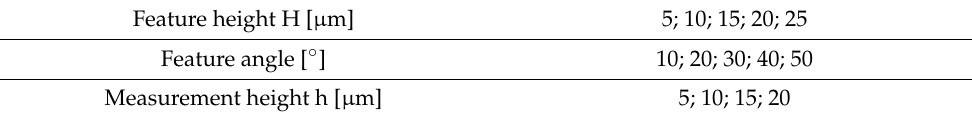
Table 1. Variables for ANSYS transient thermal